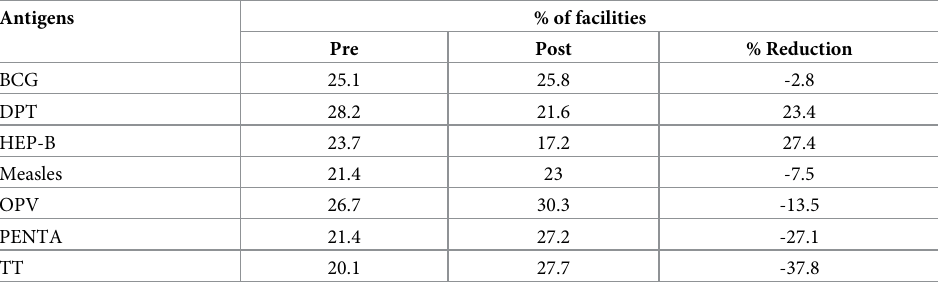
Table 6. Facilities reporting excess stock in Pre- eVIN and Post- eVIN period by antigen.